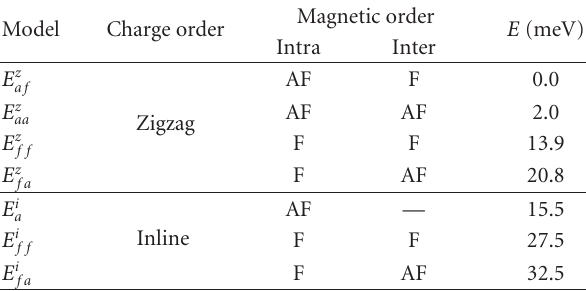
the LDA+ U method for various models for charge and magnetic ordering in α (cid:2) -NaV 2 O 5 [245]. The lowest energy of the zig-zag CO model with AF intrachain and F interchain magnetic ordering is taken as zero energy. Magnetic Model Charge order